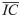
Increasing competition localization increases genetic drift.A) Experimental design for the simulations. B) The variation in frequency of the physiologically-identical genotypes, as a function of ζ. The points are means, averaged across replicates, of the standard deviation of the final genotype frequency. These means were normalized by dividing by the maximum standard deviation. The error bars are standard error. The horizontal error bars are standard error of the mean of ζ, due to different founder locations causing different IC¯ (see Materials and Methods).